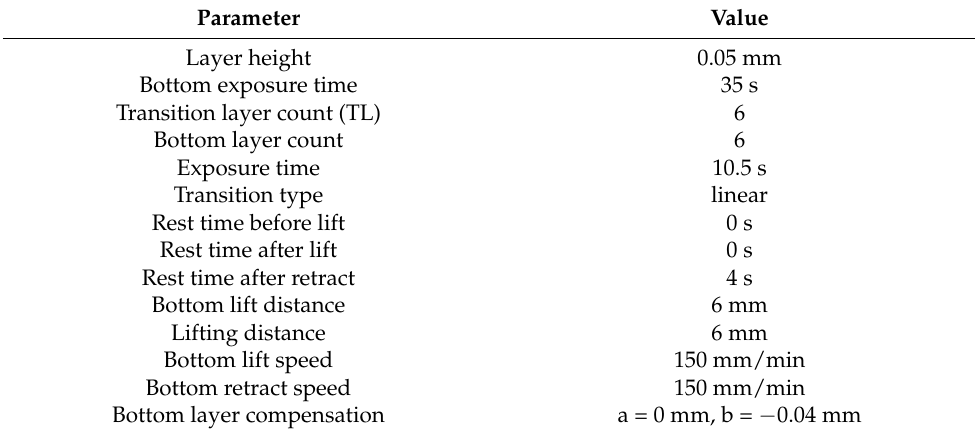
Table 3. DLP manufacturing